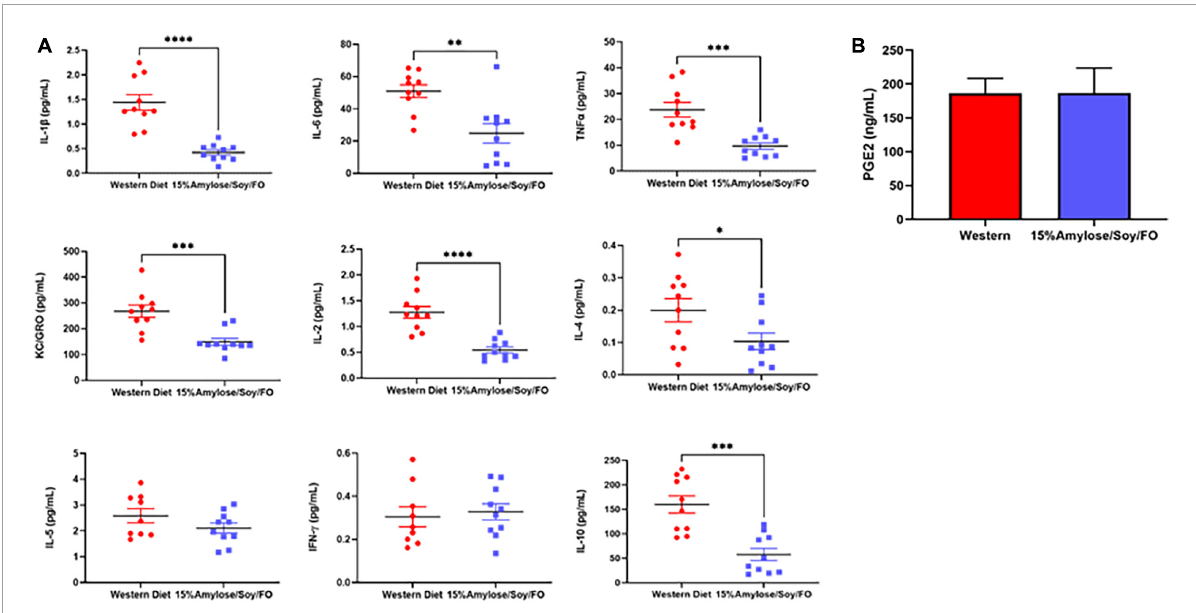
FIGURE5 A 15%Amylose/Soy/FO diet reduces inflammatory cytokines in 6-month-old miR-146a KO mice. (A) Mesoscale analysis of IL-1 β , IL-2, IL-4, IL-5, IL-6, KC/Gro, TNF α , IFN γ , and IL-10 plasma levels from miR-146a KO mice on a Western vs. a 15%Amylose/Soy/FO diet at 6 months of age. The data are shown as the mean ± SEM of 10 miR146a KO mice on a Western and 10 miR146a KO mice on a 15%Amylose/Soy/FO diet. (B) Plasma PGE 2 levels of miR146a KO mice on a Western vs. a 15%Amylose/Soy/FO diet at 6 months of age. The data are shown as the mean ± SEM of 10 miR146a KO mice on a Western and 10 miR146a KO mice on a 15%Amylose/Soy/FO diet. NS = not significant, ∗ P < 0.05, ∗∗ P < 0.01, ∗∗∗ P < 0.001, ∗∗∗∗ P <